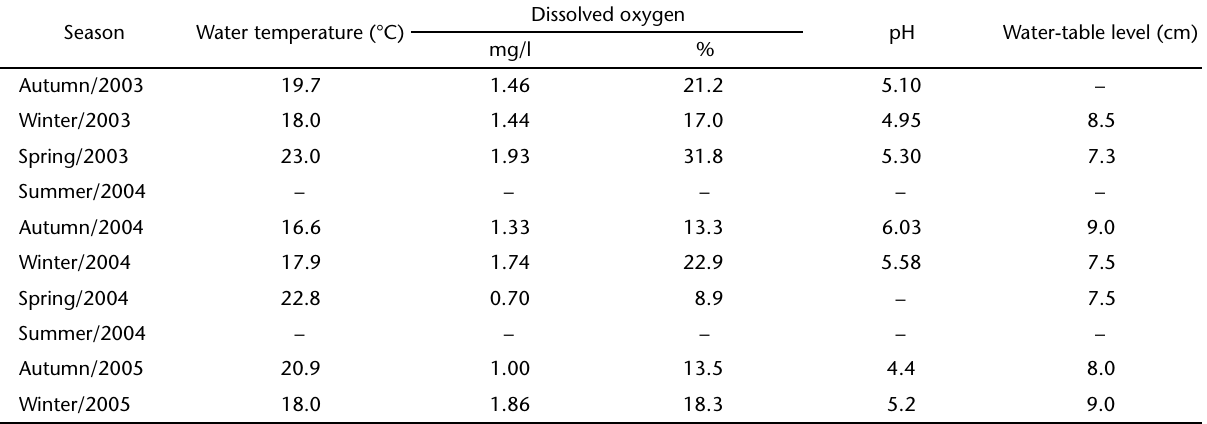
Table I. Physical and chemical parameters (seasonal means) of the water in burrows of P. defossu s in Lami, Porto Alegre, from May 2003 through August 2005. Season